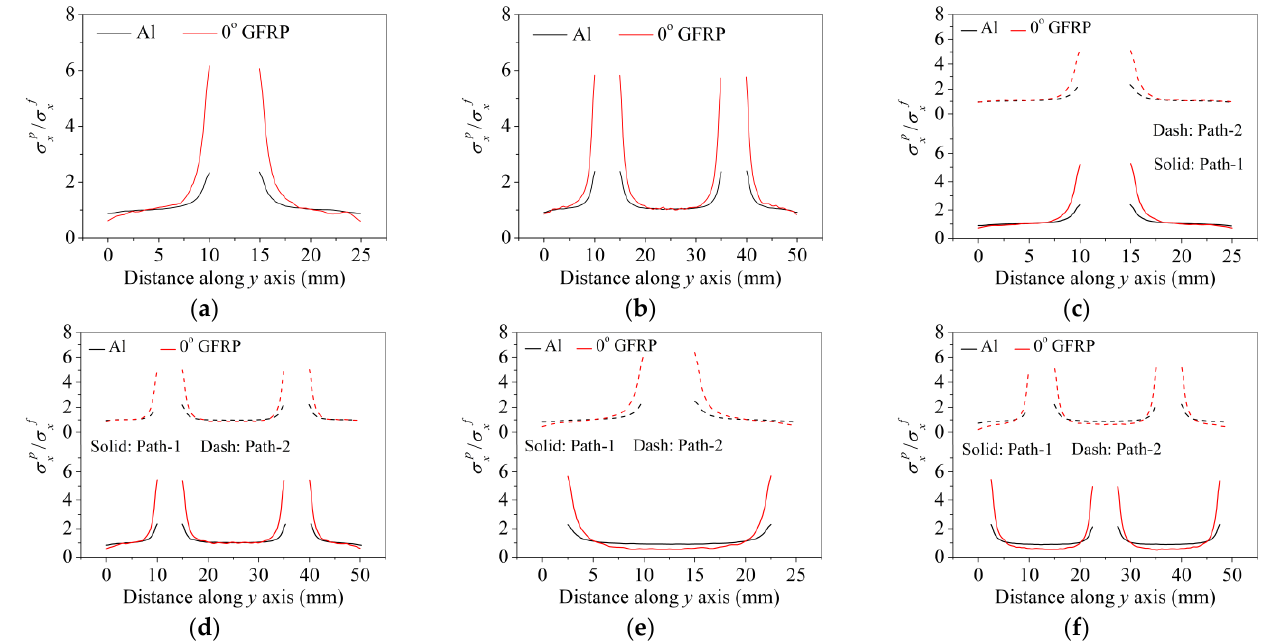
Figure 6. Axial stress distributions in on-axis Glare specimens: ( a ) H1R1; ( b ) H2R1; ( c ) H2R2P; ( d ) H4R2P; ( e ) H3R2S; ( f ) H5R2S.